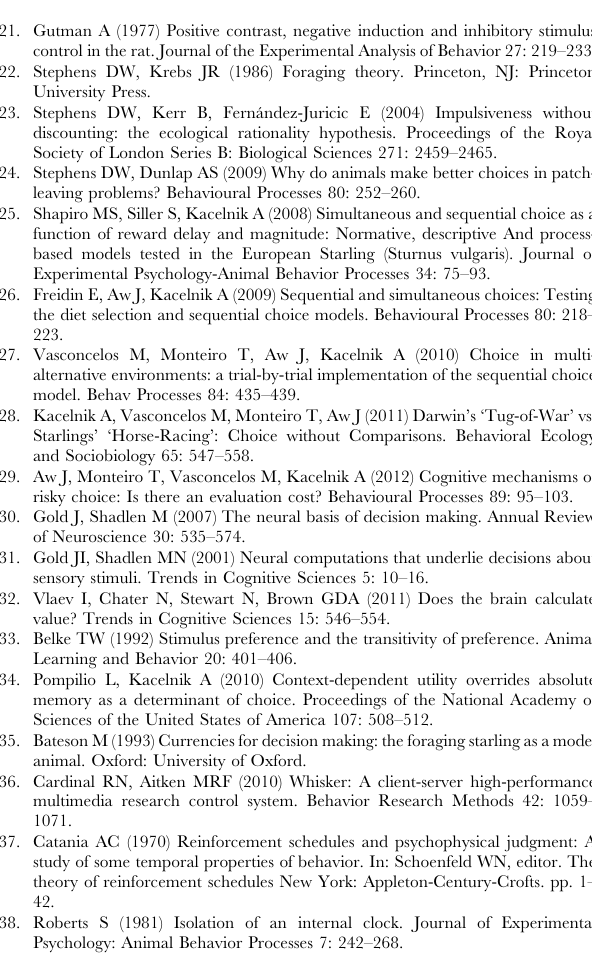
Figure S1 Average cumulative frequency distribution of latencies for each option during sequential encounters. The greater the area below each function the shorter the overall latencies to accept that particular option. Figure S2 Average cumulative frequency distribution of latencies for each option in single-option and simulta- neous choice trials. Triangles and dots represent data from single-option and simultaneous choice trials. Latencies are separated according to collection time: either at stability in the A 5 vs. C 10 preference tests or at stability in the B 10 vs. C 10 preference tests. (A) Distributions for A 5 in the A 5 vs. C 10 preference tests. (B) Distributions for B 10 in the B 10 vs. C 10 preference tests. (C) Distributions for C 10 in the A 5 vs. C